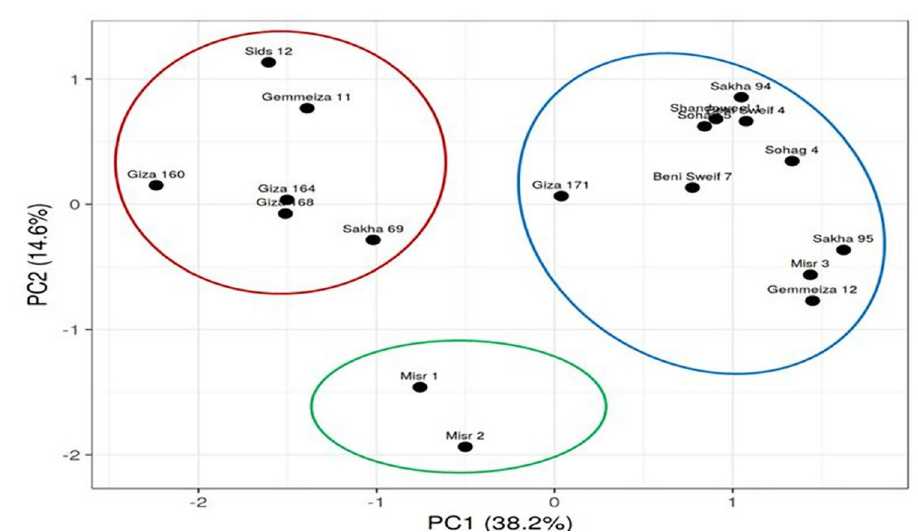
Fig 2. Principal component analysis (PCA) based on the rust races scoring data. The figure demonstrates a sharp clustering into three distinctive groups (blue) resistance to stem rust in the seedling stage; (green) moderate susceptible to stem rust races in the seedling stage; genotypes; (red) highly susceptible to stem rust races in seedling stage genotypes; wheat genotypes). https://doi.org/10.1371/journal.pone.0257959.g002 genotypes and ranged from 0 to 80 S for stem rust and from TrMr to 70 S for leaf rust. The highest final stem rust severity percent was recorded for Giza 160, Giza 164, Misr 2, Sakha 69 and Misr1genotypes either at Giza or Sids, but the lowest final stem rust severity% was noticed. Table 4. These seedling reaction of 18 Egyptian wheat cultivars tested against 13 races of P . graminis tritici under greenhouse conditions. Wheat Cultivar P . graminis